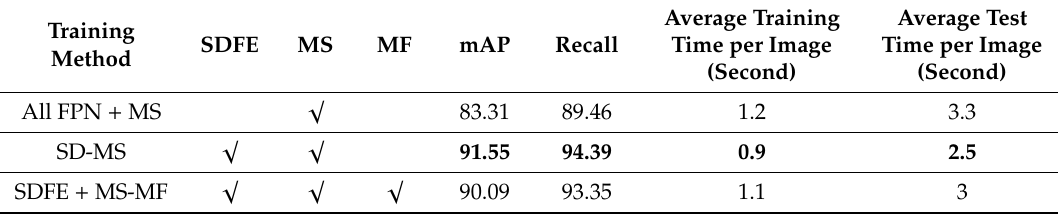
Table 2. Comparisons of each experiment on the VHR-10 dataset, showing the components and results of mAP and recall for each experiment and the execution time of training and test.